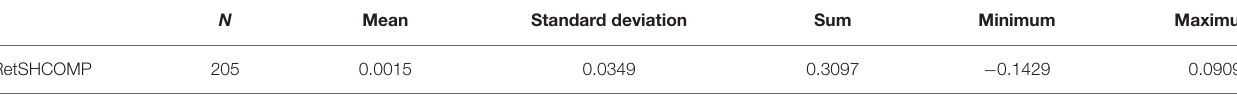
TABLE 4 | Basic descriptive statistics of return rate data.